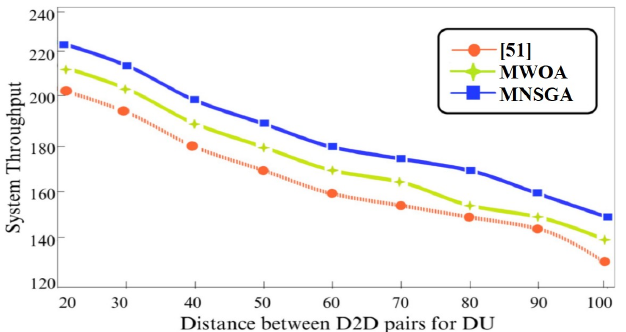
Figure 10. Throughputs for various distances between D2D pairs for DU s.